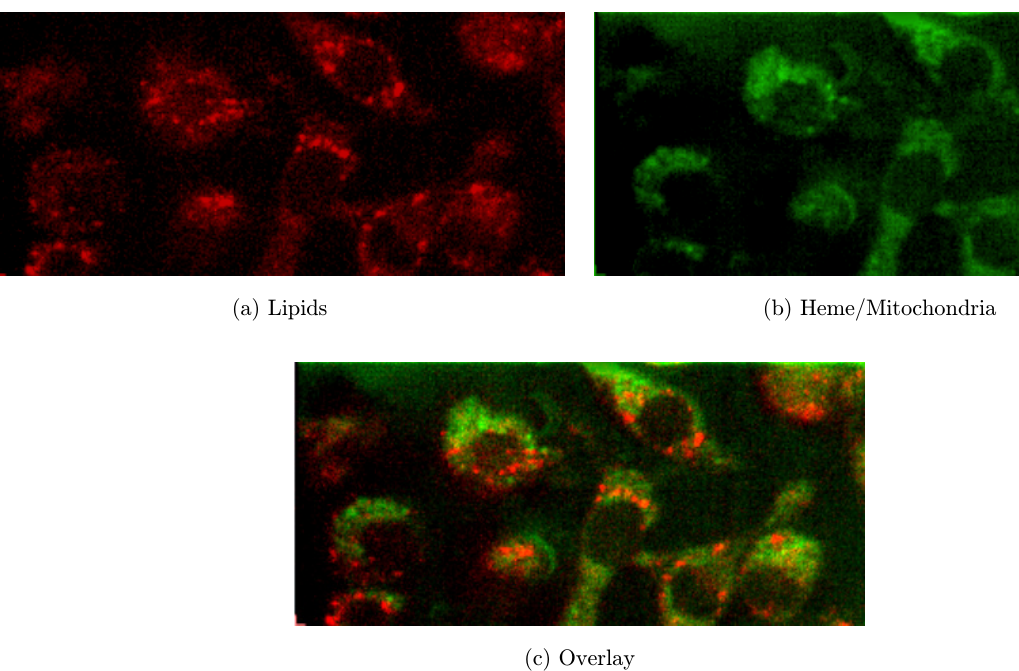
Fig. 1. Label-free Raman imaging of living macrophage MH-S cells, showing two observable components. (a) Lipid band (2850 – 2870 cm (cid:1) 1 ), (b) Heme band (752-758 cm (cid:1) 1 ), (c) Overlay of both channels.